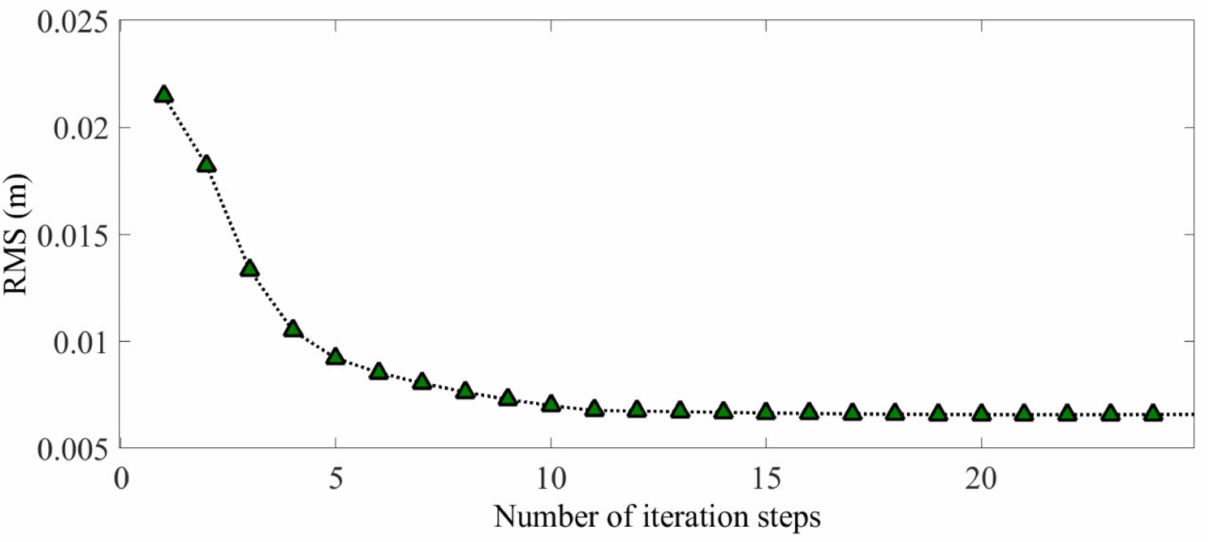
Figure 9. The precision of the mesh